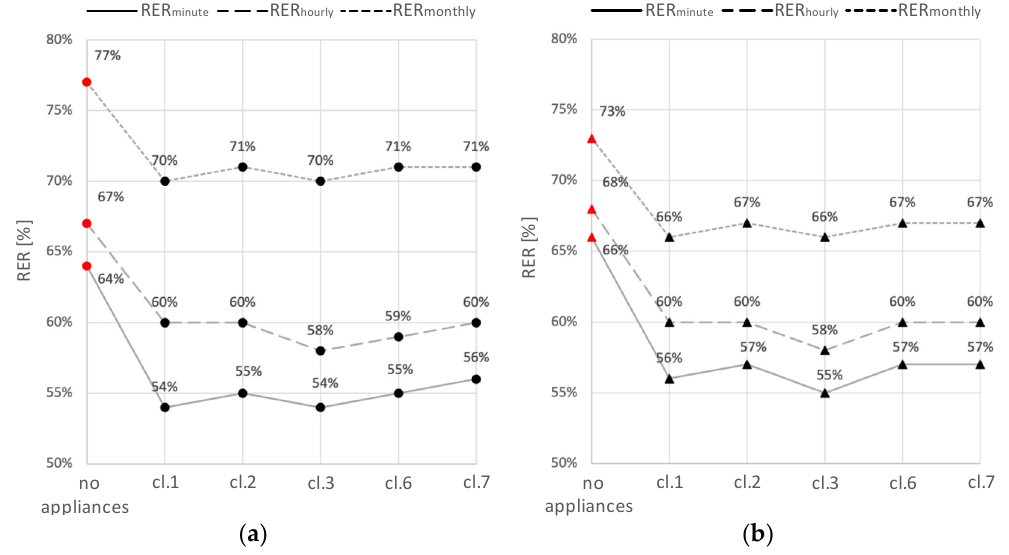
Figure 6. Annual values of RER minute , RER hourly and RER monthly : TRNSYS results for the MF building in Trento, without (red) and with appliances (black) and bas ( a ) or enh ( b ) controls.